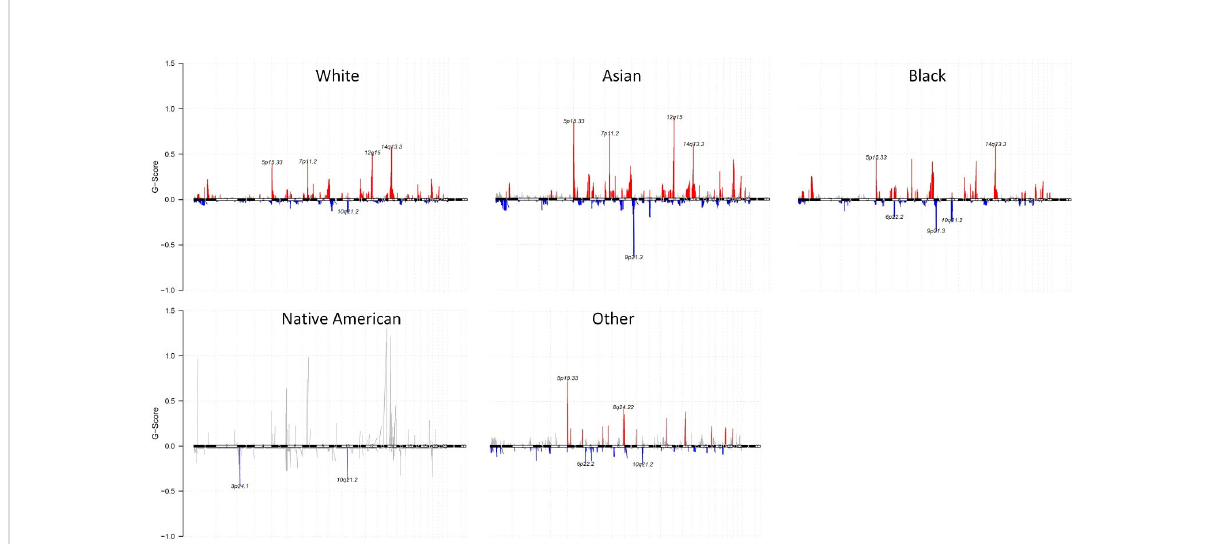
FIGURE 4 Gene CNAs of each race with G-Score. Gene CNAs possibility de fi ned by G-score (G = Frequency × Amplitude) of White, Asian, Black, Native American, and Other. Gene copy number ampli fi cations were shown as red, and gene copy number deletions were shown as